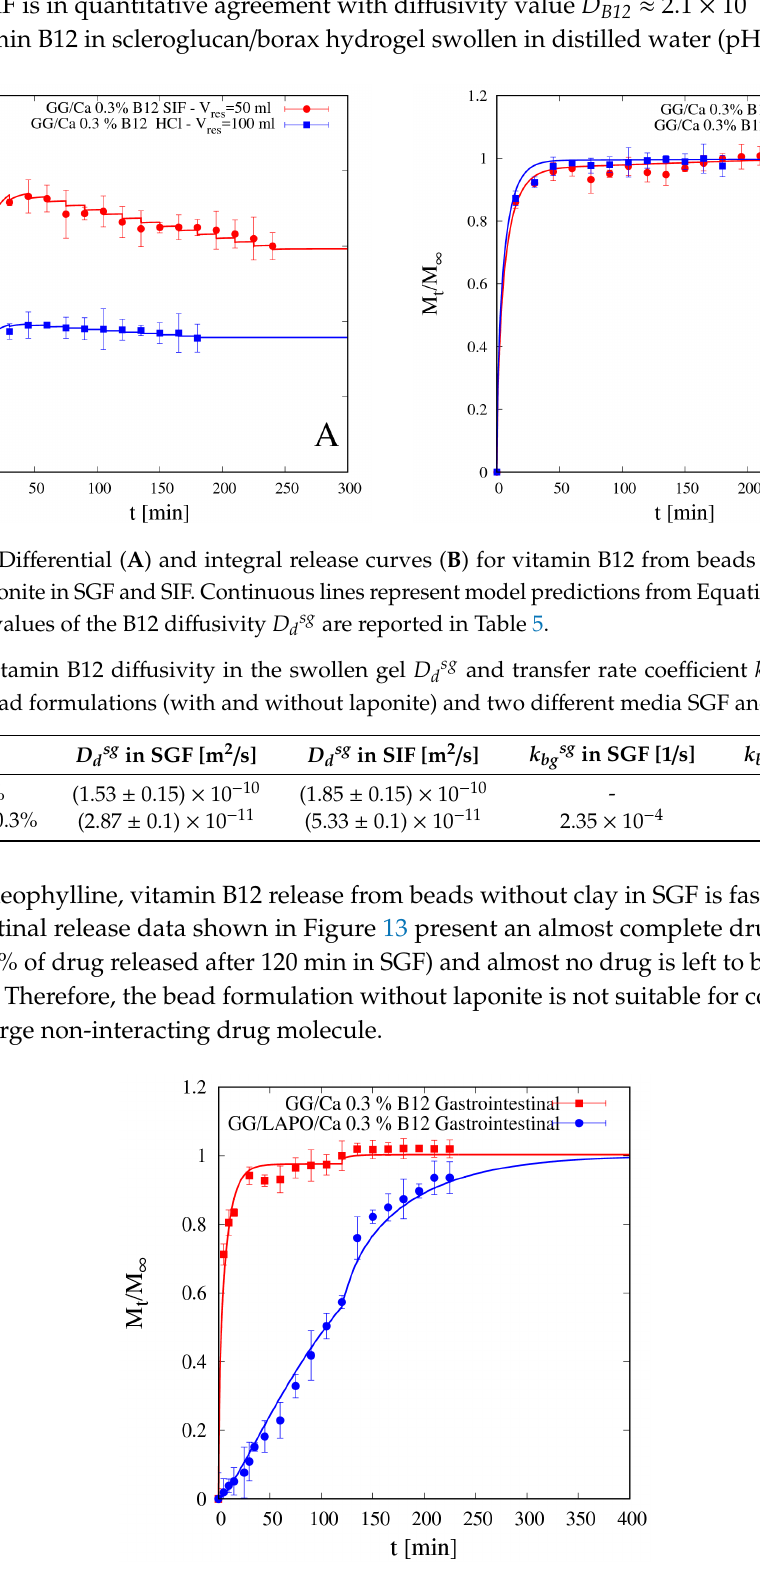
Figure 13. Gastrointestinal integral release curve for vitamin B12 from beads GG/Ca 0.3% with and without laponite ( p < 0.001 ). Continuous lines represent model predictions for the Fickian release model from Equations (11)–(13) and for the two-phase release model from Equations (13)–(16) with model parameters reported in Table 5.